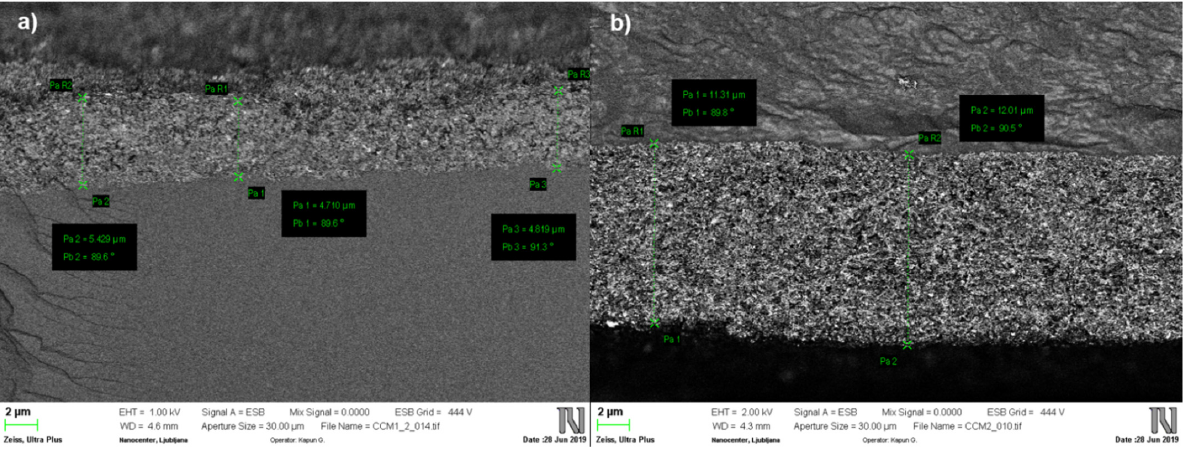
Figure 2. Cross sectional SEM of prepared catalyst layers used for layer-thickness determination of: ( a ) MEA 40/0.125, ( b ) MEA 20/0.125.